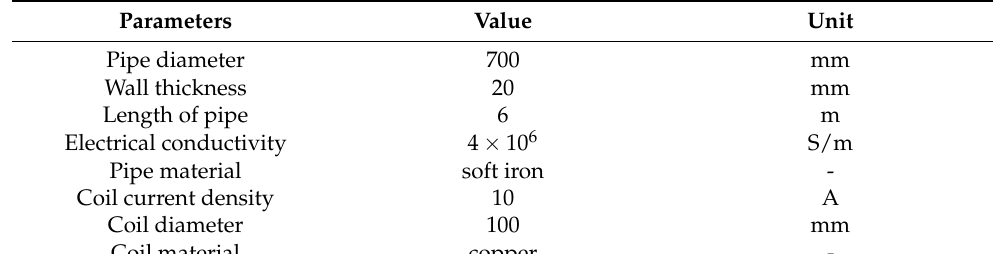
Table 1. Values of the parameters that were used in the FEM model.